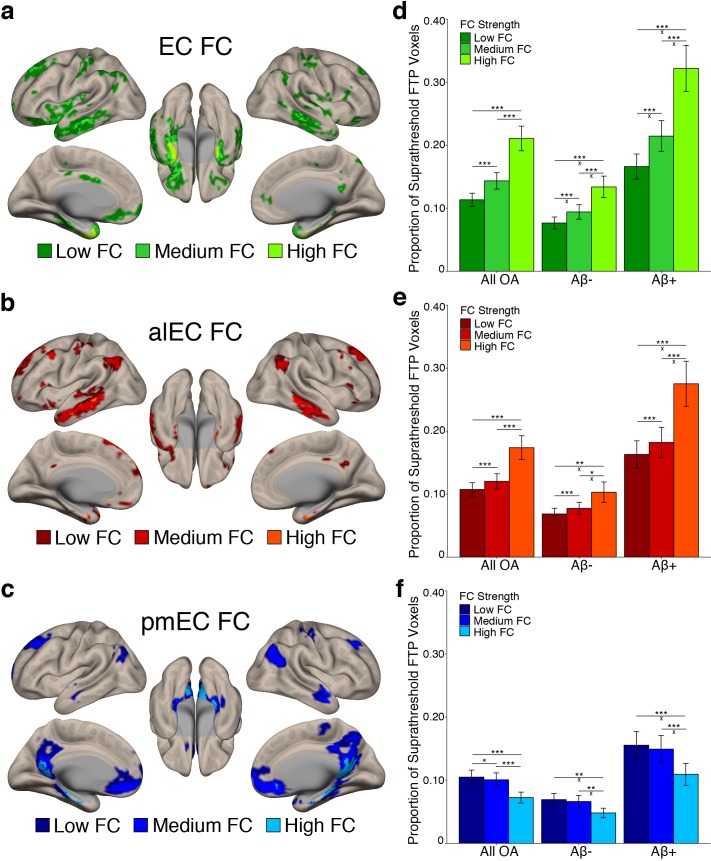
Stronger FC with a region is associated with higher levels of tau deposition in that region.(a-c) To examine associations between tau and FC strength, group level YA FC masks for each EC seed were clustered into regions of low, medium, and high FC based upon the mean YA FC strength (beta value) of each voxel. (d-f) The proportion of suprathreshold FTP voxels (>1.4 SUVR) was calculated for each FC strength region (‘tau deposition’). Repeated measures ANCOVAs and post-hoc t-tests were performed to contrast tau deposition between each FC strength region. (d) EC FC strength was significantly related to tau deposition in a stepwise pattern, with tau increasing in low < medium < high FC regions. Aβ status interactions were observed between all comparisons. (e) Increasing alEC FC strength was also related to higher tau deposition in a stepwise fashion, and Aβ interactions were driven by the difference between high-medium and high-low FC regions. (f) Increasing pmEC FC strength was associated with decreases in tau deposition, and Aβ interactions were driven by the difference between high-medium and high-low FC regions. See Figure 3—figure supplement 1 for parallel results using OA FC. ***p<0.001, **p<0.01, *p<0.05; ‘x’ indicates the drivers of significant Aβ interactions (p<0.05). Error bars indicate the standard error of the mean.10.7554/eLife.49132.015Figure 3—source data 1.Source data for the data visualized in Figure 3.